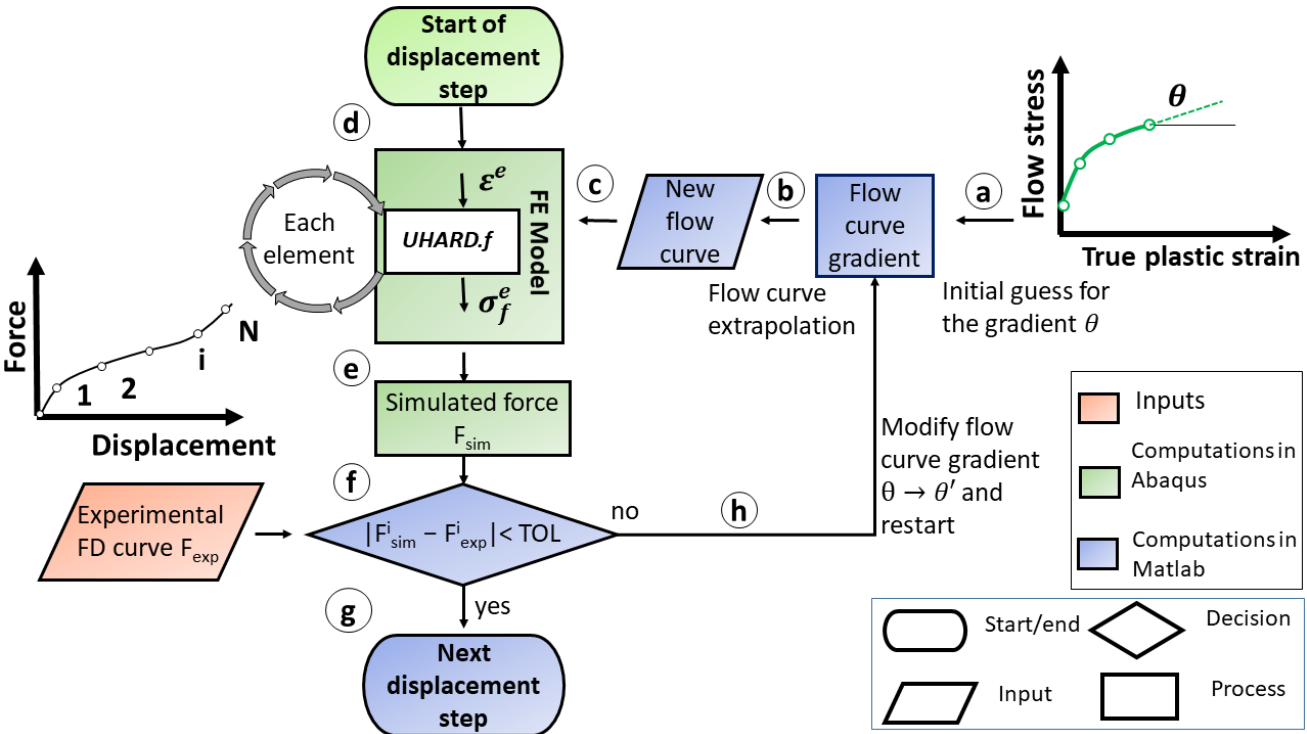
Figure 3. Block diagram of the iterative scheme in flow curve determination through explicit piecewise inverse modeling (FepiM).